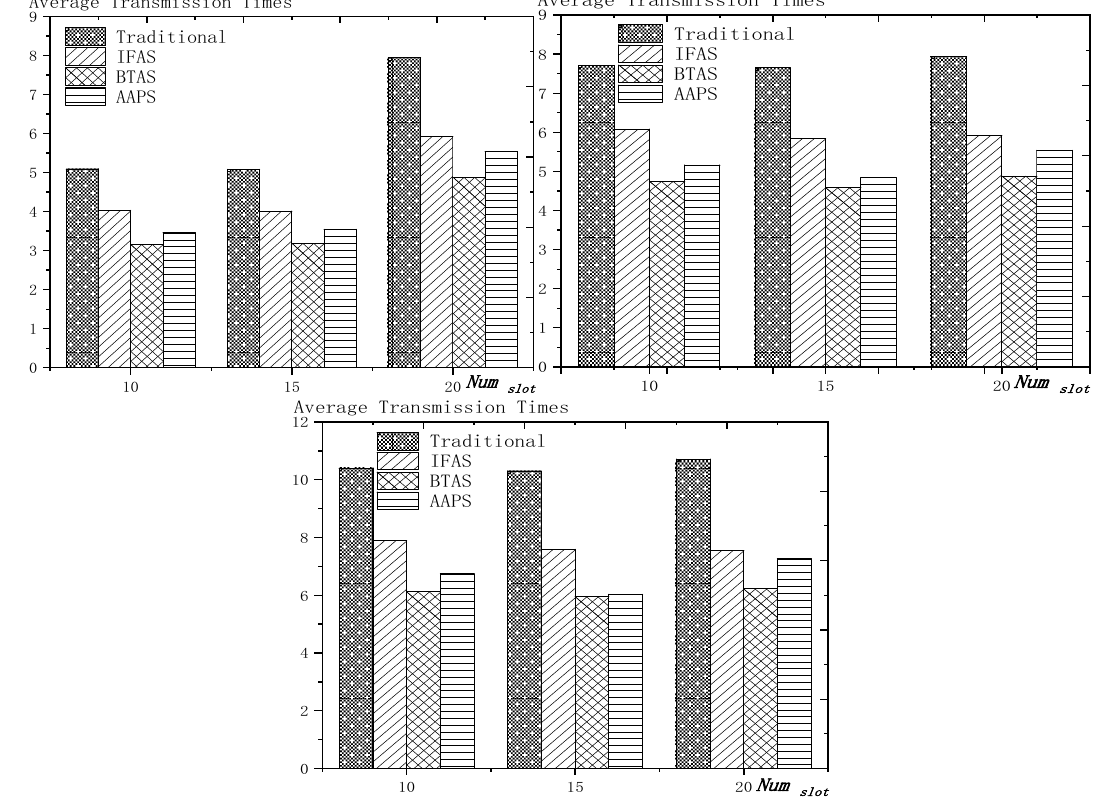
Figure 21. The average transmission times with Num slot as variable (setting 1, setting 2, setting 3). Table 12. The improvement of transmission times compared with the traditional algorithm. (cid:2170)(cid:2203)(cid:2195) (cid:2201)(cid:2194)(cid:2197)(cid:2202) IFAS (Setting 1, Setting 2, Setting 3) Num